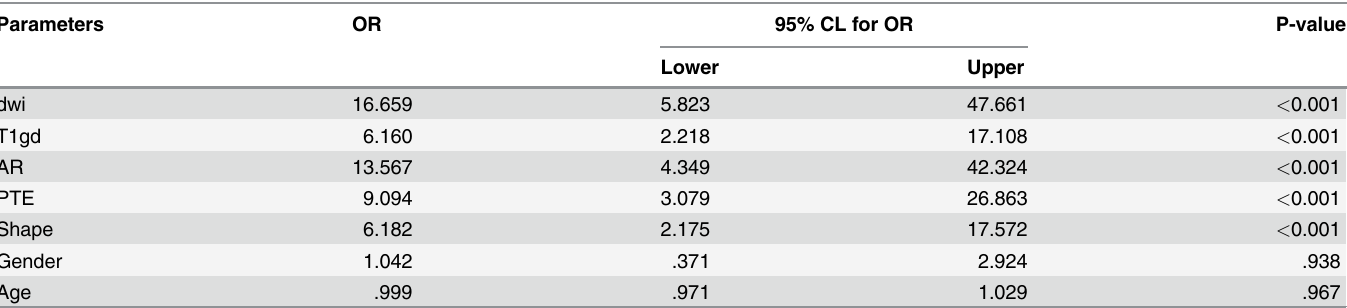
Table 2. Logistic Regression analysis for the clinical and radiological parameters as predictors of WHO non-grade I meningioma.